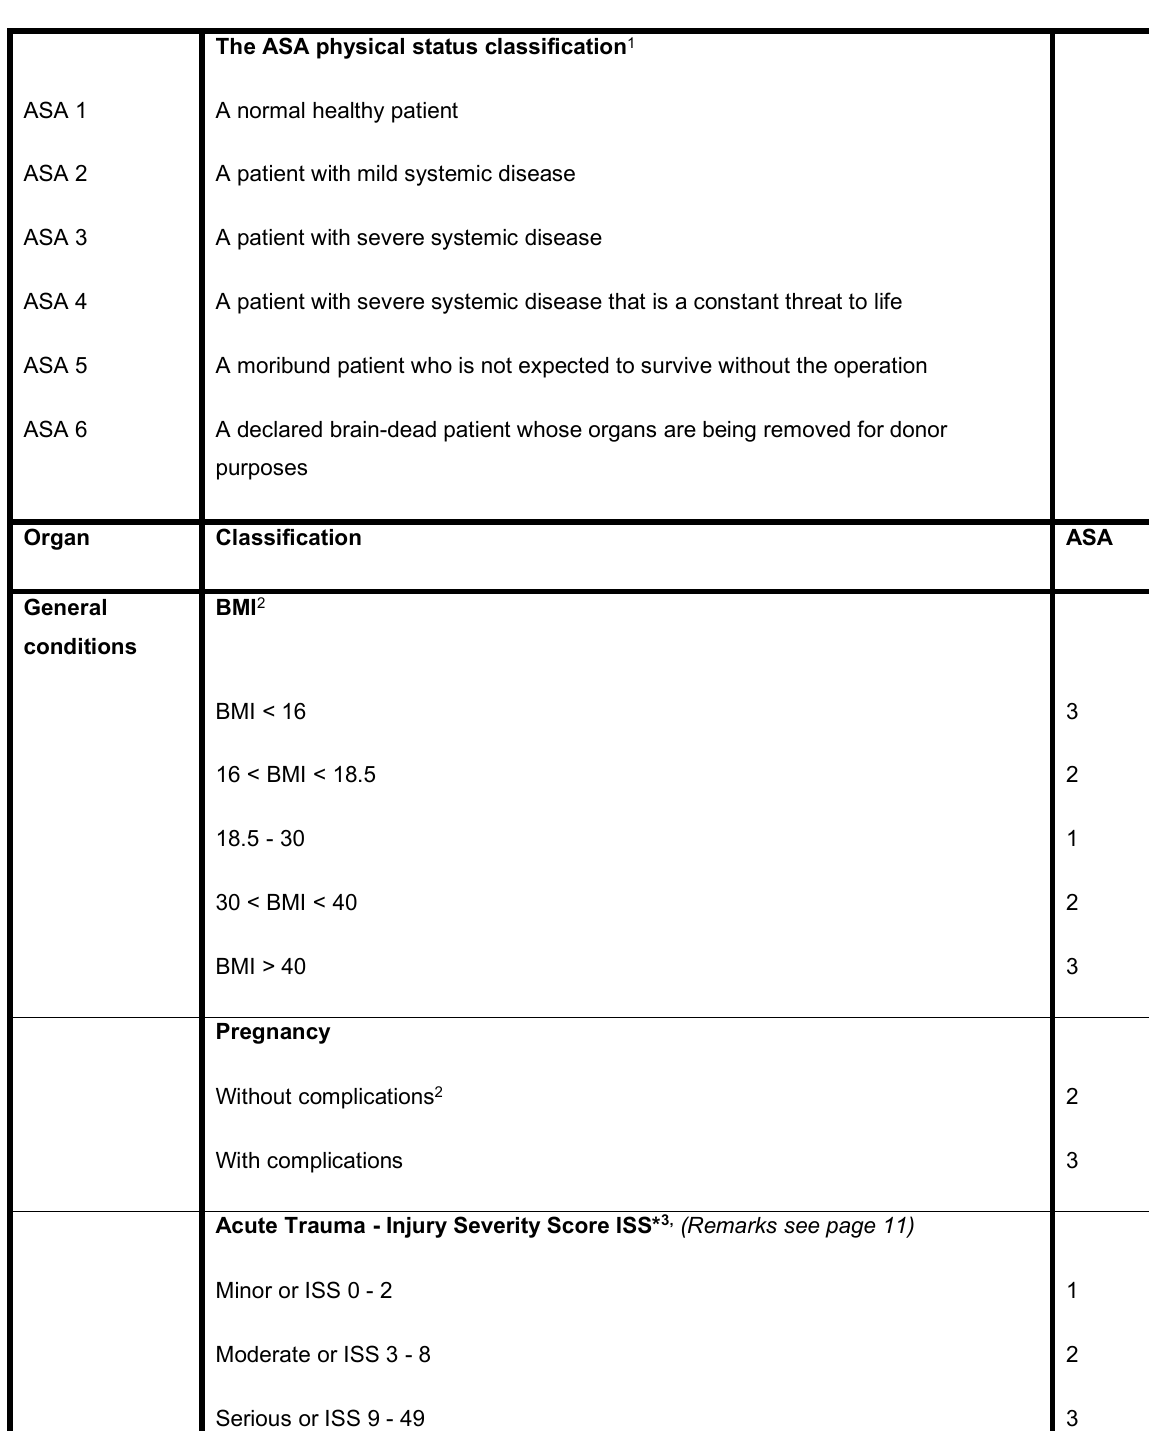
Table 1: ASA physical status relevant comorbidities and corresponding ASA class